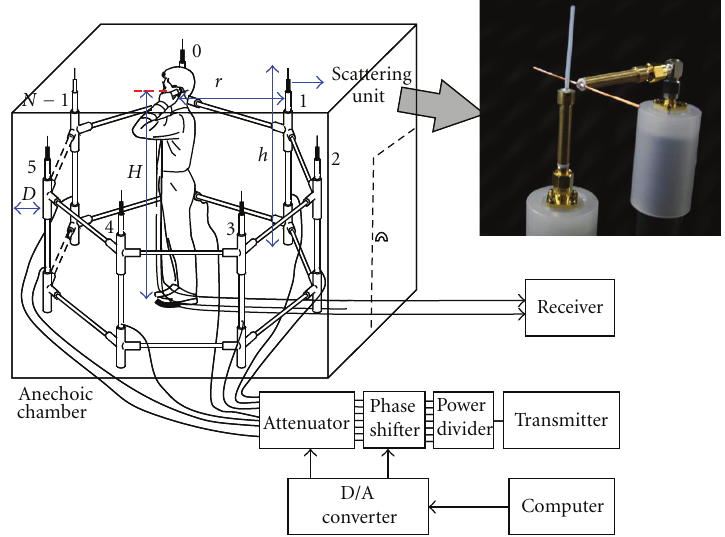
Figure 5: Experimental setup of the spatial fading emulator (TR 37.976 [7] Figure 6 . 3 . 1 . 5 .